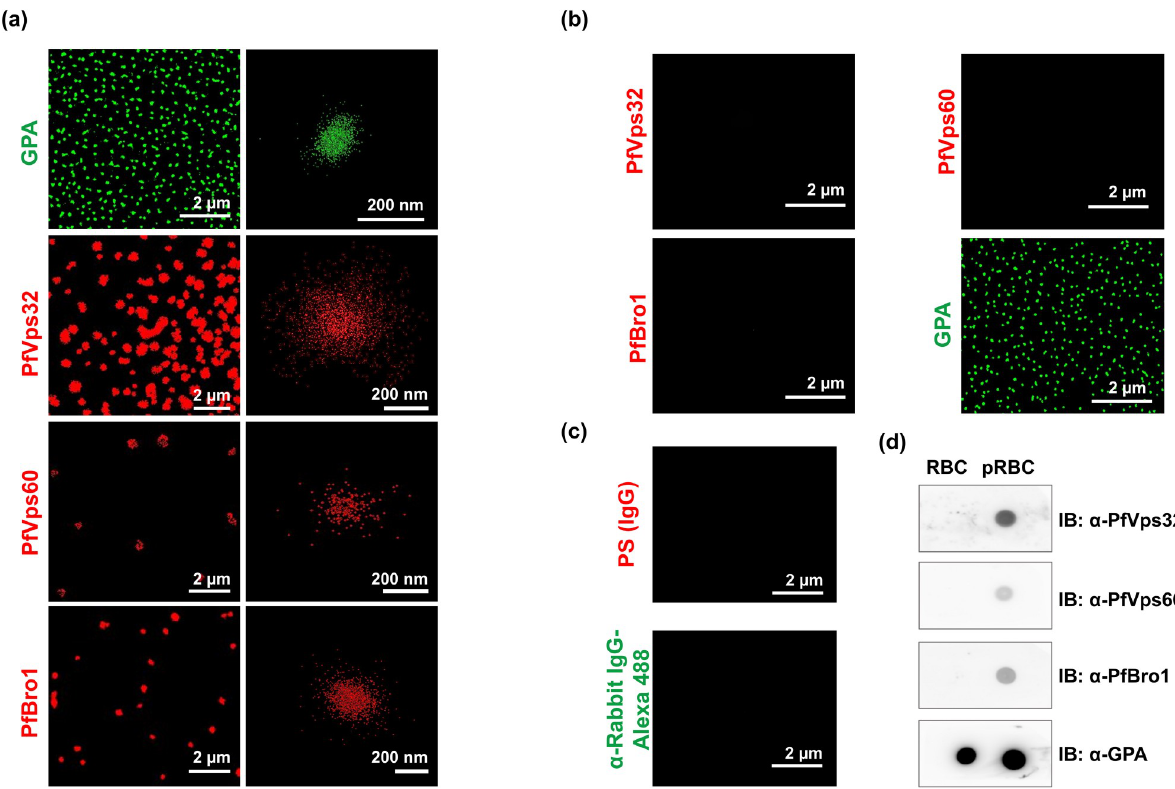
Fig 2. PfVps32, PfVps60 and PfBro1 proteins are present in EVs produced by pRBCs. (a) STORM detection by immunostaining of GPA, PfVps32, PfVps60 or PfBro1 in purified EVs derived from a 3% parasitemia, 3% hematocrit pRBC culture at 40 hpi. On the right column are shown images of individual EVs. (b) STORM detection as in (a) but using EVs derived from a 3% hematocrit RBC culture incubated for 40 h at 37˚C. (c) Control of pRBC-derived EVs immunostained with preimmune serum (PS) or secondary antibodies against rabbit IgGs. (d) Dot blot assays performed in extracts of EVs derived from pRBCs (at 40 hpi) and RBCs (after 40 h of incubation at 37˚C). https://doi.org/10.1371/journal.ppat.1009455.g002 PLOS Pathogens| https://doi.org/10.1371/journal.ppat.1009455 April 2,